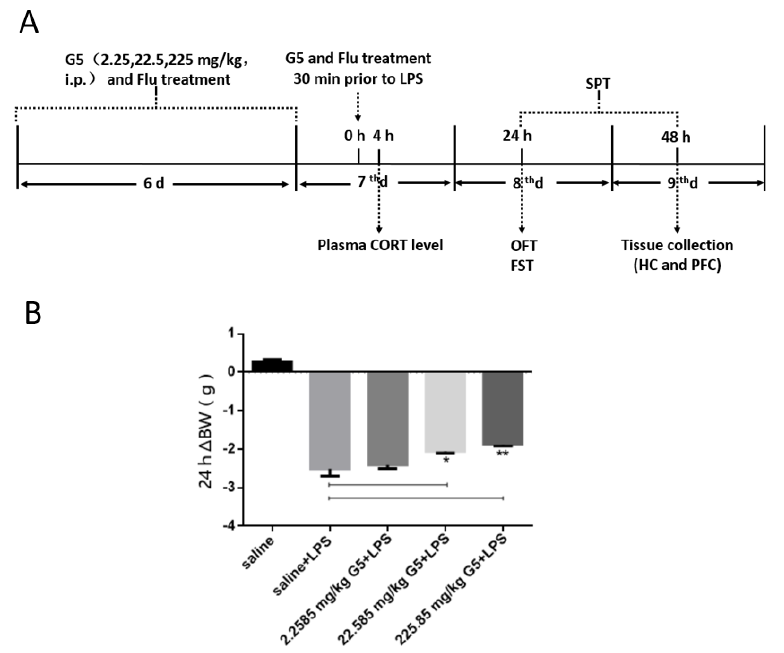
Figure 2. Effect of LPS on body weight of mice. ( A ) Schematic diagram of experimental timeline and study plan. ( B ) Body weight loss at 24 h after LPS challenge; G5 can recover the bodyweight in a dose dependence manner. * p < 0.05, ** p < 0.01 for one-way ANOVA followed by Fisher’s least significant difference test; n = 7, all data are presented as mean ± SEM.